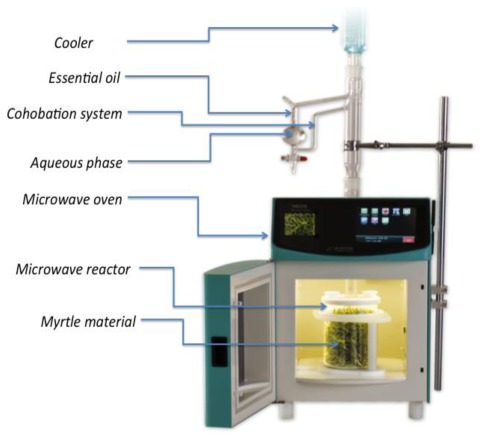
Microwave—Clevenger.